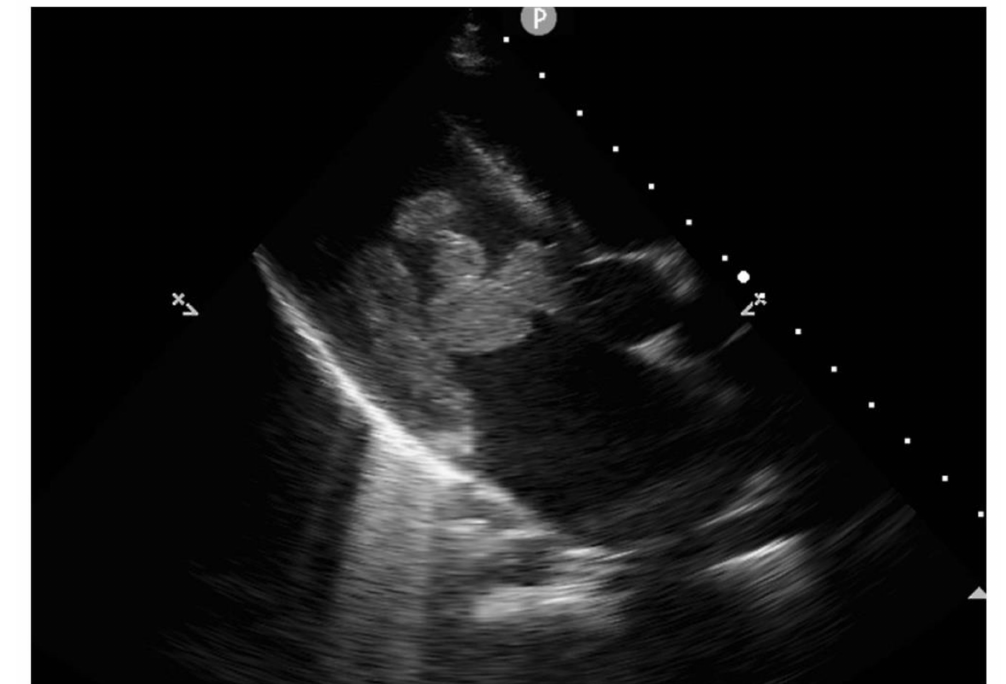
Figure 7. Echocardiography shows numerous vegetations at the mitral level, of different shapes and dimensions, obstructing the left ventricular inflow, with high mobility especially of the most distal one.